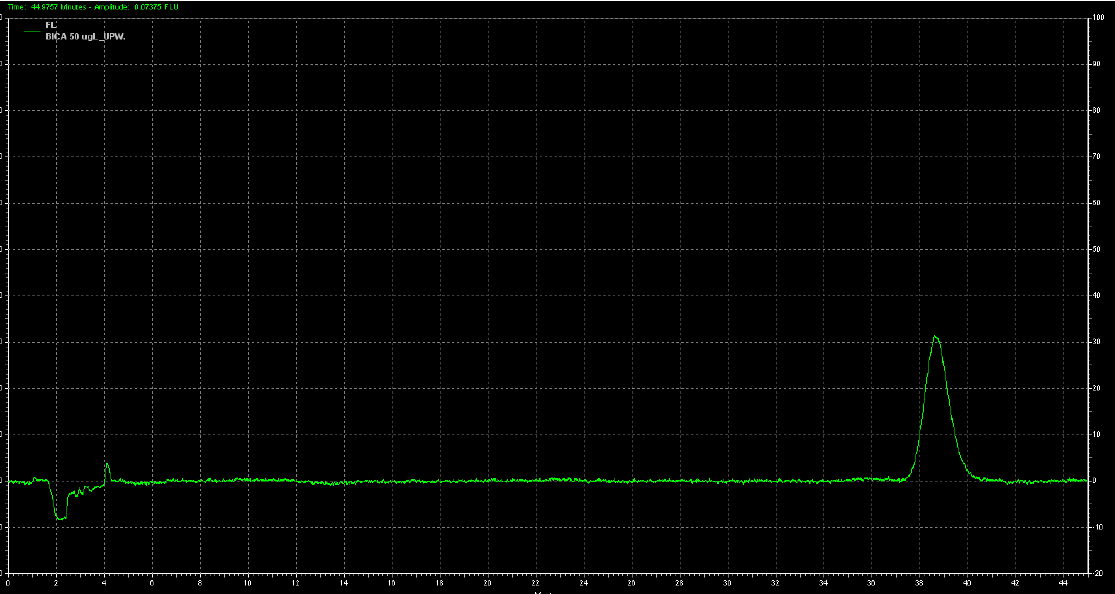
Figure A1. HPLC–FLD chromatogram of a 50 ng/mL BICA standard in ultrapure water, using the method’s final conditions: 0.2 mL/min as flow rate; 65:35 UPW:ACN, both acidified with 0.1% formic acid, as mobile phase; and 272/318 nm as excitation/emission wavelengths.